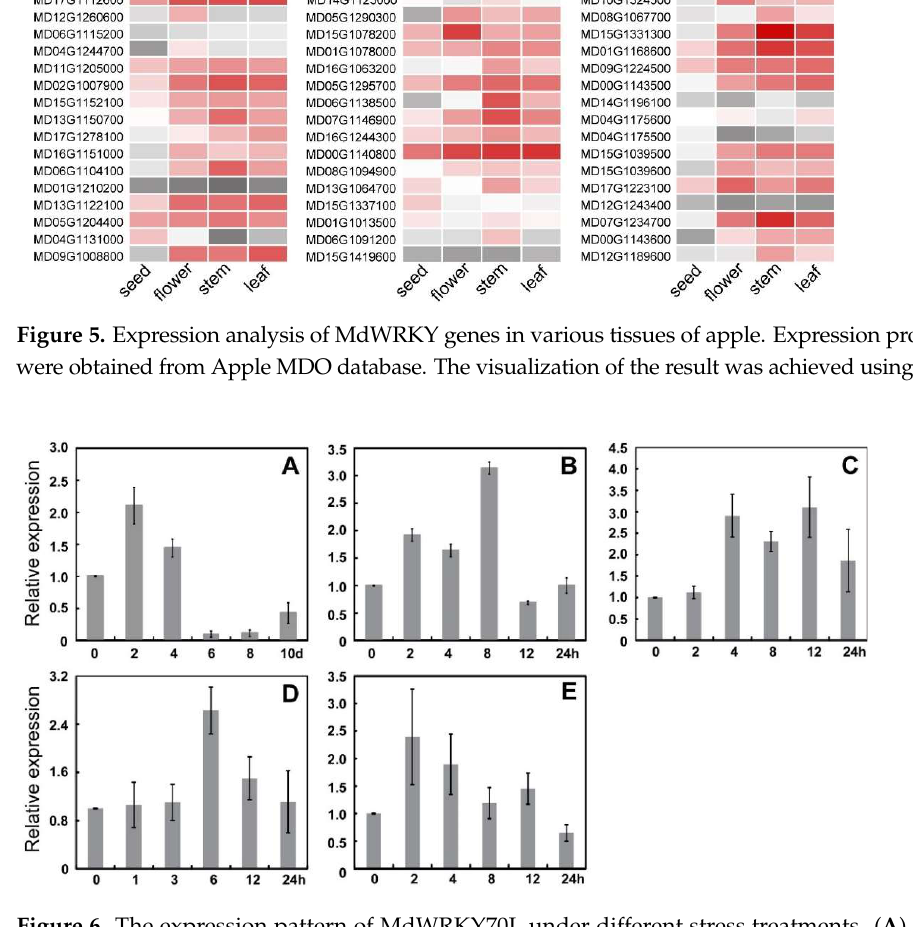
Figure 5. Expression analysis of MdWRKY genes in various tissues of apple. Expression profile data were obtained from Apple MDO database. The visualization of the result was achieved using TBtools.